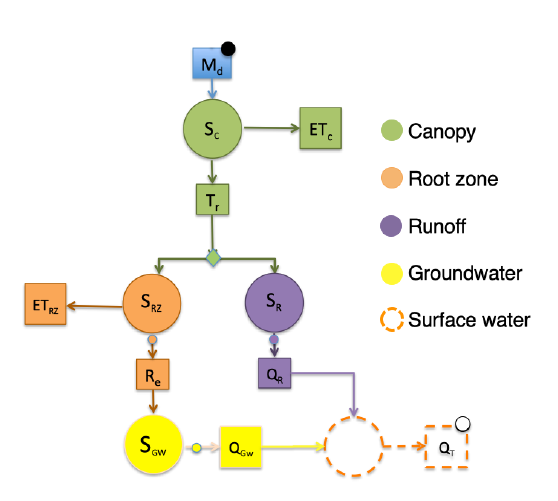
Figure 2. Representation of the simplified embedded reservoir model. The four components—canopy, root zone, surface flow, and groundwater—are represented by Extended Petri net using circles with different colors and specifications. Table 1. List of symbols, names, and units used in the sERM representation. P indicates a calibrated parameter, P* indicates a parameter to be set from the literature, P • indicates a measured parameter, SV indicates a state variable, and F indicates flux. The definitions also include the symbols defined in the expression table